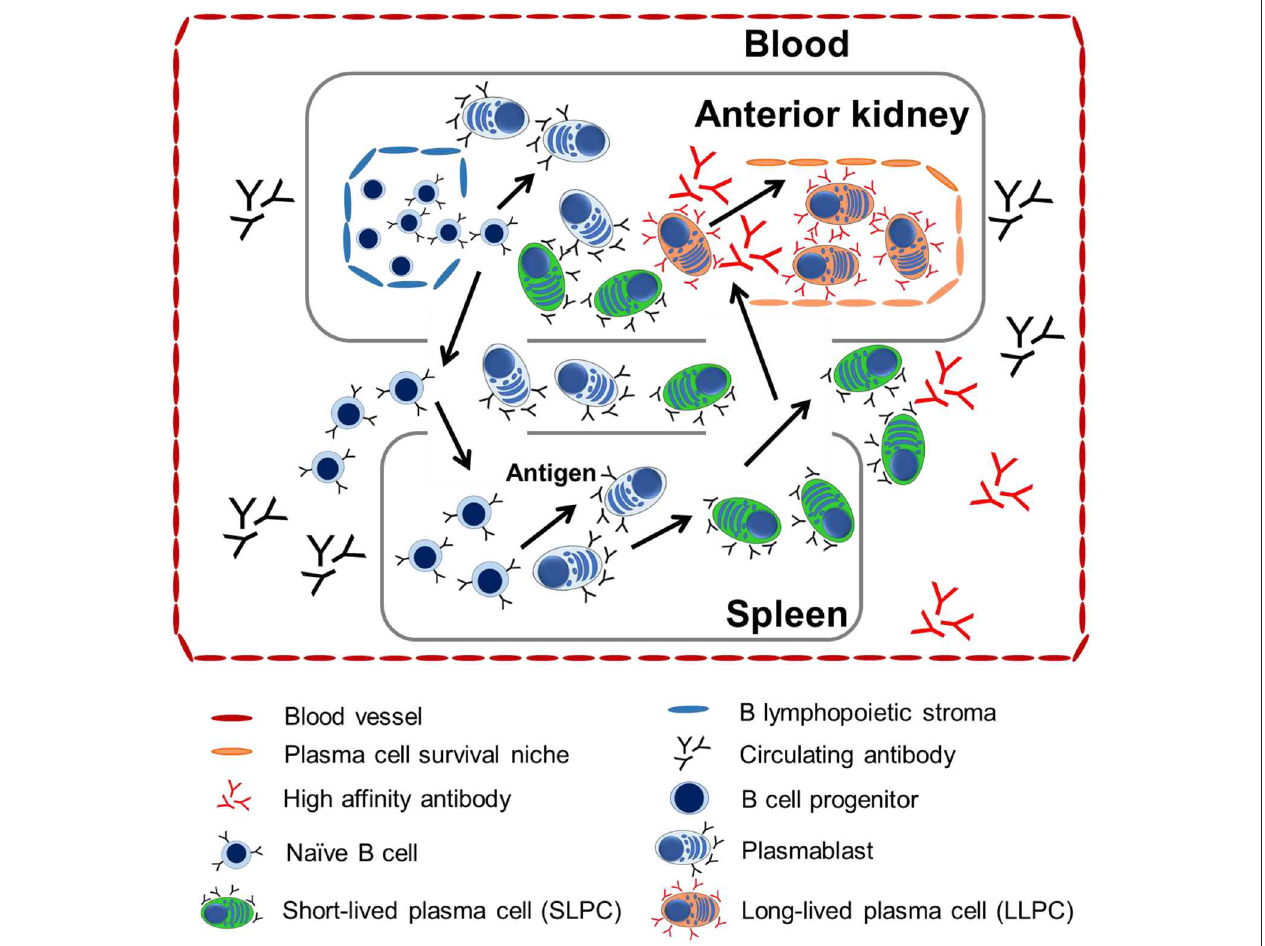
FIGURE 7 | A proposed model of tissue distribution and migration of LLPCs from teleosts. Anterior kidney is the bone marrow-like tissue posing the major site of B lymphocyte development where B cell progenitors and naive B cells arise. They migrate to peripheral tissue via the blood. When these B cells encounter antigen, they mature into plasmablasts or PCs in either the anterior kidney or spleen. Plasmablasts or PCs differentiate within the spleen and anterior kidney, but home to the anterior kidney, wherein PCs from all tissues compete for long-term maintenance within the survival niches in the anterior kidney.